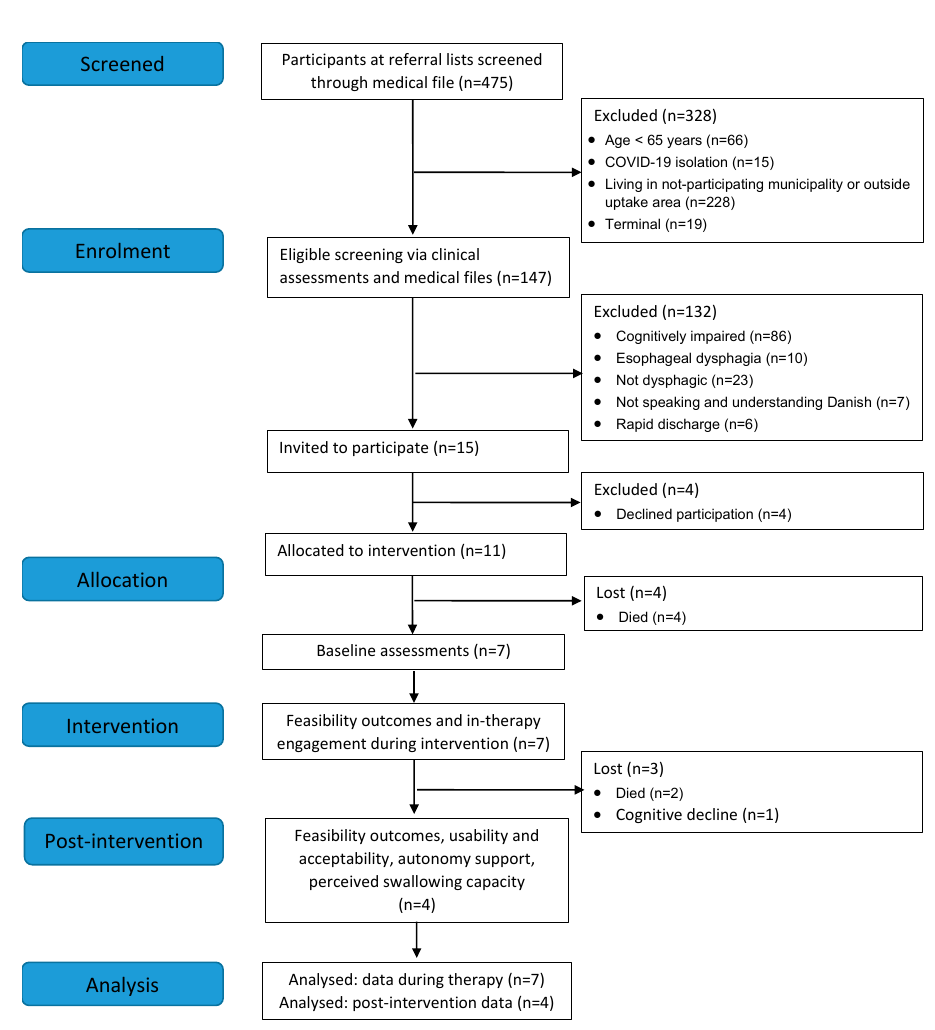
Table 1. Baseline demographic and clinical characteristics.